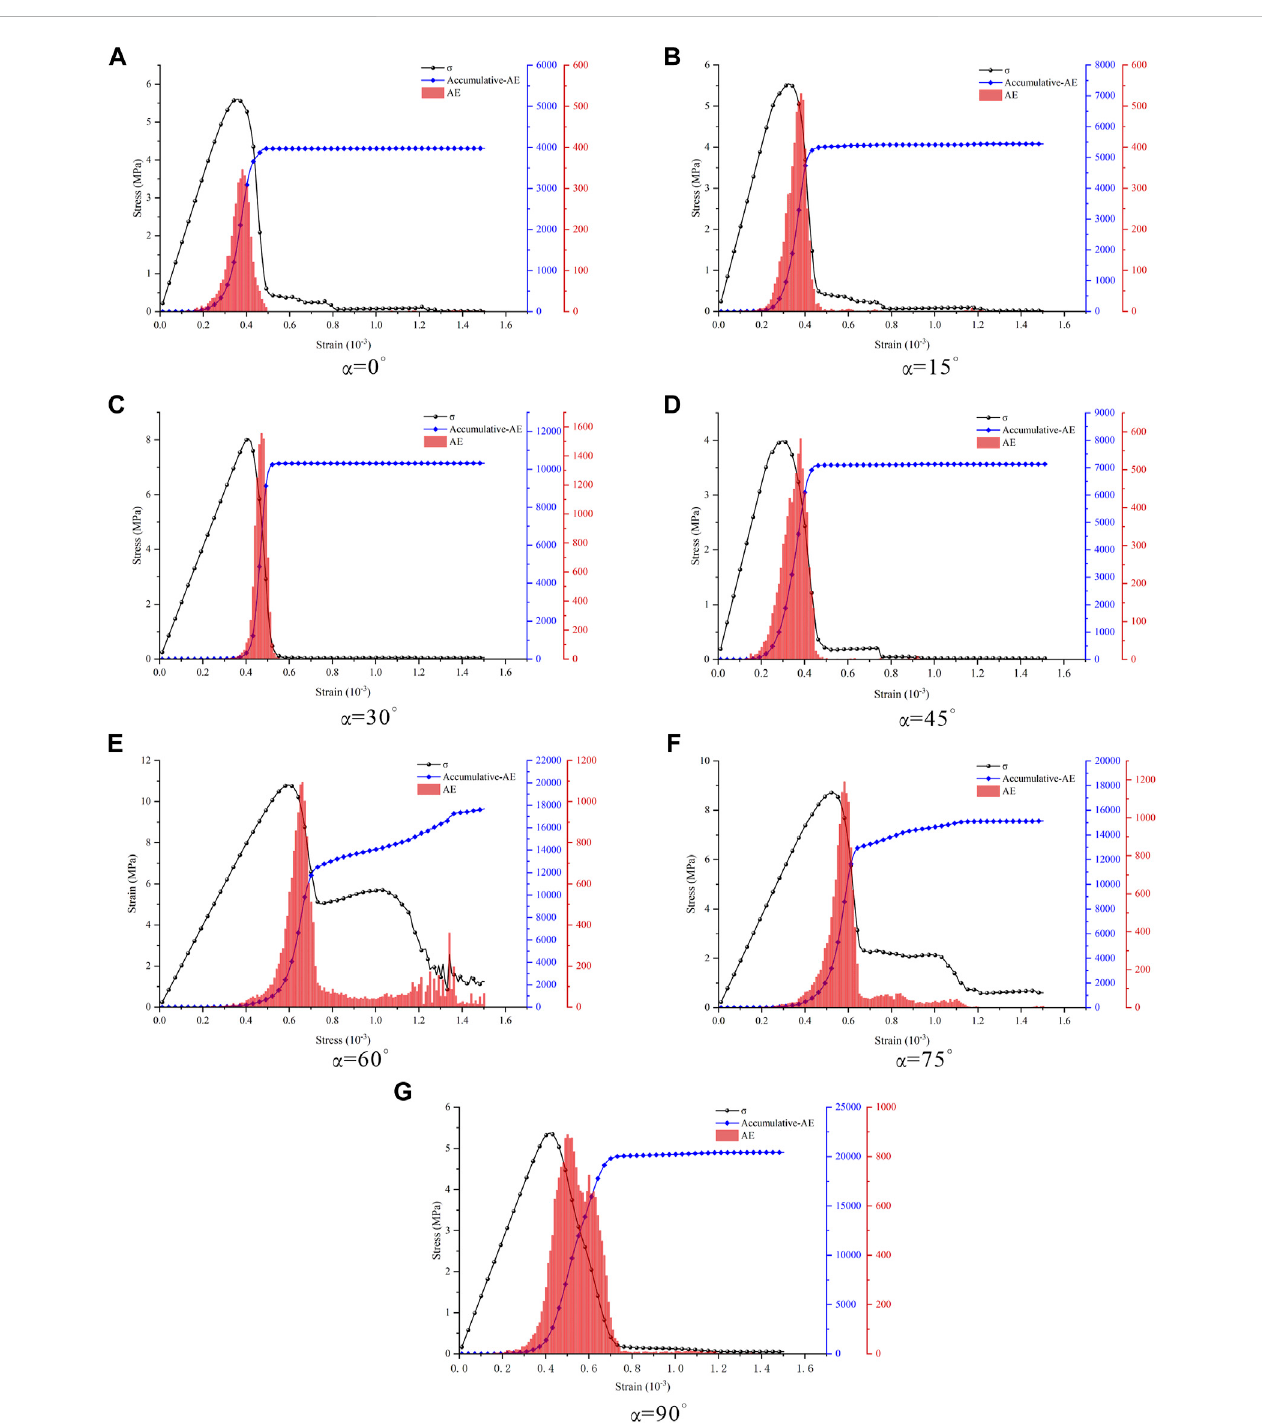
FIGURE 11 Trend of stress, AE, and cumulative AE with strain at different α . (A) α = 0 ° . (B) α = 15 ° . (C) α = 30 ° . (D) α = 45 ° . (E) α = 60 ° . (F) α = 75 ° . (G) α = 90 ° .